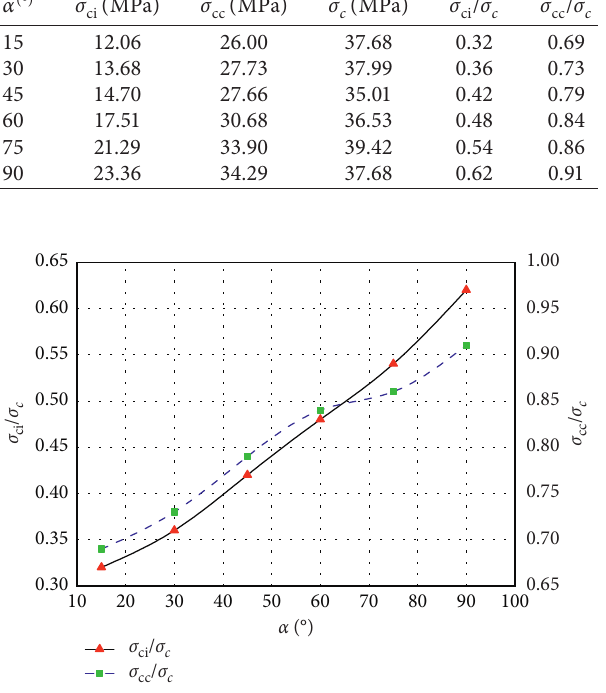
Figure 9: Joint persistency k versus crack initiation and coales- cence forces σ / σ c and σ / σ c . ci cc